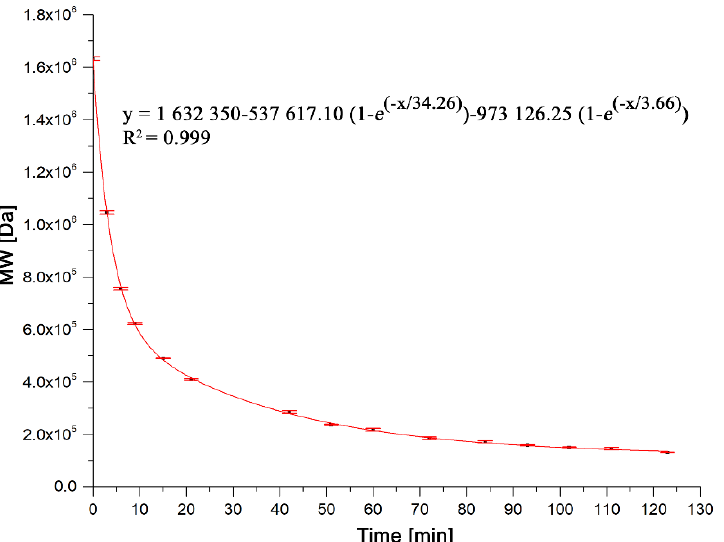
Figure 11. Reduction of chitosan MW with ultrasound (20 kHz) exposure